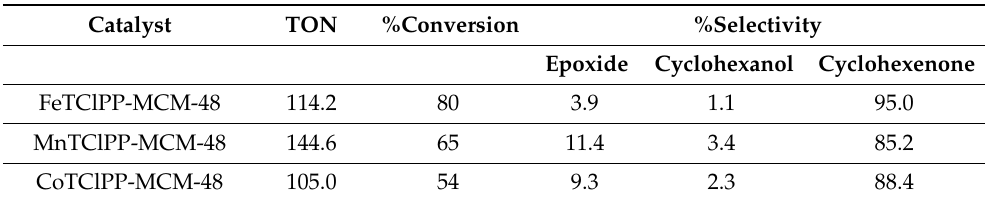
Table 3. Oxidation of cyclohexene using FeTClPP, MnTClPP and CoTClPP porphyrins incorporated in MCM-48